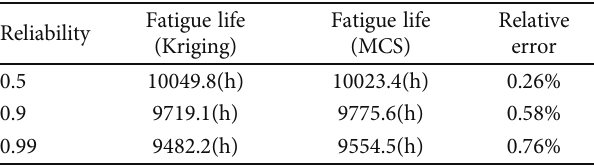
Figure 14: Comparison of MCS and Kriging (test probe). Table 10: Test probe fatigue life prediction.